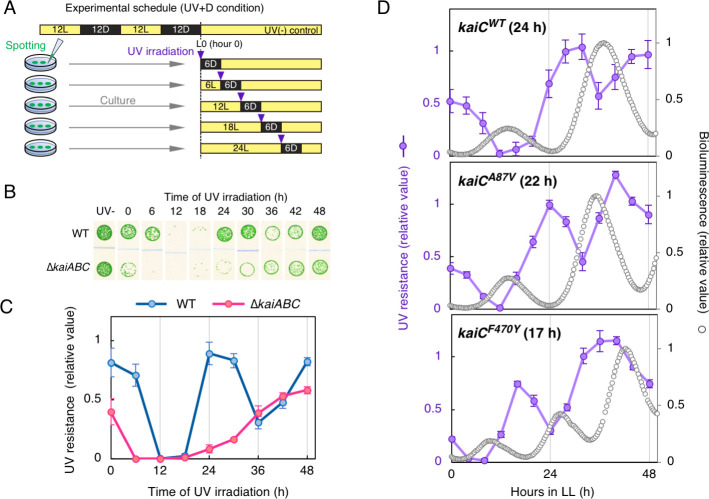
Synechococcus shows circadian variation of resistance to UV-C immediately followed by exposure to darkness.(A) A schematic representation of the experimental schedule (UV+D condition). Each symbol is the same as in Fig 1A. Cells were acclimated to 6 h of darkness after UV-C irradiation. (B) Growth of UV-C-irradiated cells. Each image represents a spot assay to assess growth following UV irradiation at each time point (upper label) under the UV+D condition. Representative data of three independent experiments are shown. (C) Densitometric analysis of the growth test in Fig 2B. The timing of UV irradiation is shown on the horizontal axis, and the relative UV resistance is shown on the vertical axis, as in Fig 1C (n = 3). Error bars represent standard deviation. (D) Time profiles of UV-C resistance in periodic mutants. Each panel represents the results in control strain (Top), kaiCA87V mutant (middle), kaiCF470 mutant (bottom), respectively. Free-running period of each strain is noted in upper left of each panel. Densitometric data of UV resistance are represented with violet lines and filled circles (n = 3). The timing of UV irradiation is shown on the horizontal axis, and the relative UV resistance is shown on the vertical axis on the left. Bioluminescence rhythms of each strain are also shown with open circles. Each strain harbored the PkaiBC::luxAB reporter cassette, and the bioluminescence rhythms were measured under continuous light (LL) condition without UV. The levels of bioluminescence are shown on the vertical axis on the right.